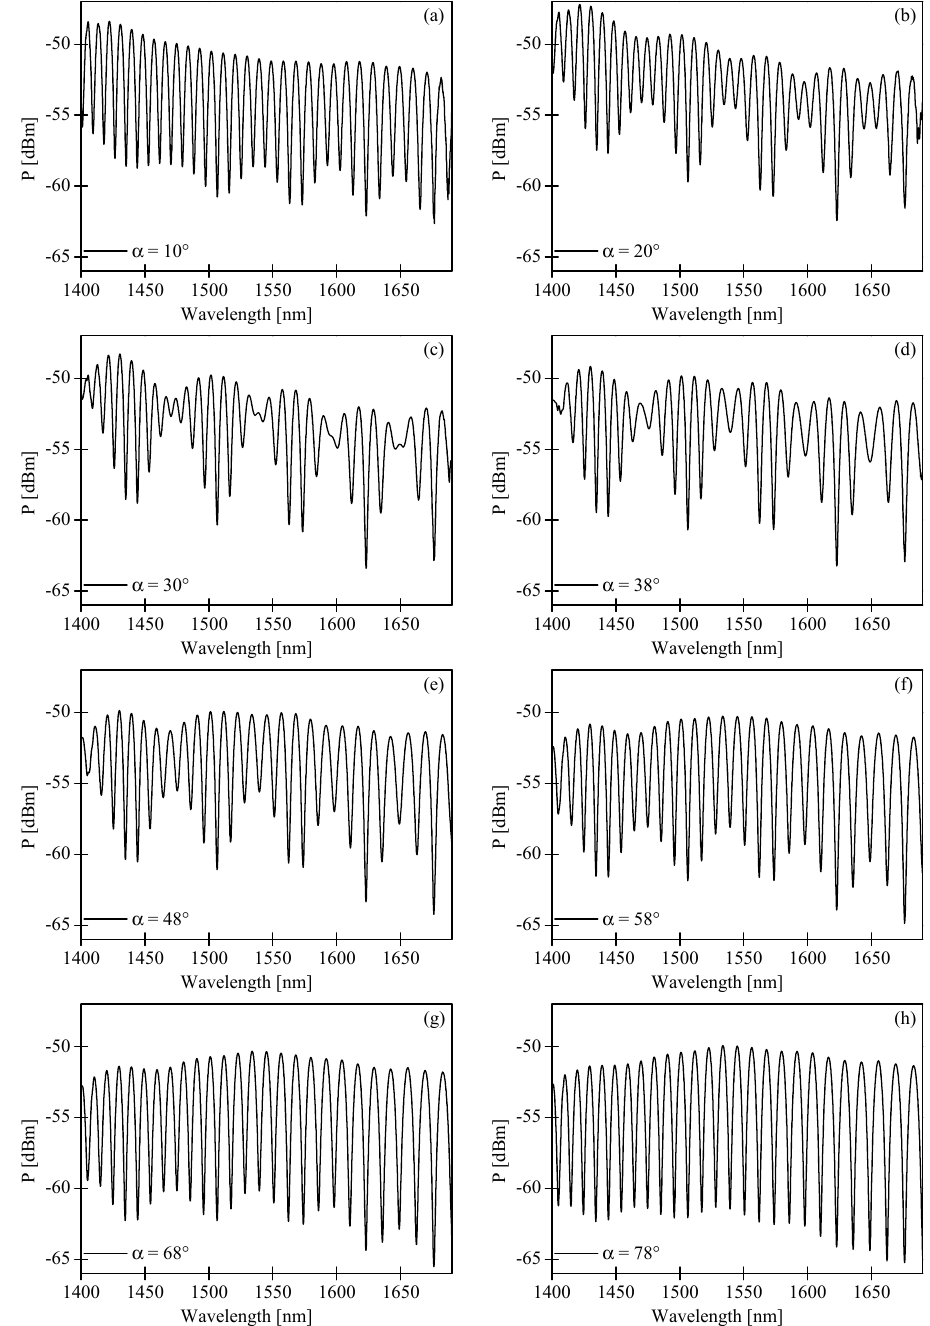
Figure 5. Spectral interference fringes at the output of the in-line intermodal interferometer based on the 56-mm long HB MOF registered for different azimuth of the input polarization state: α = 10° ( a ); α = 20° ( b ); α = 30° ( c ); α = 38° ( d ); α = 48° ( e ); α = 58° ( f ); α = 68° ( g ); α = 78° ( h ).